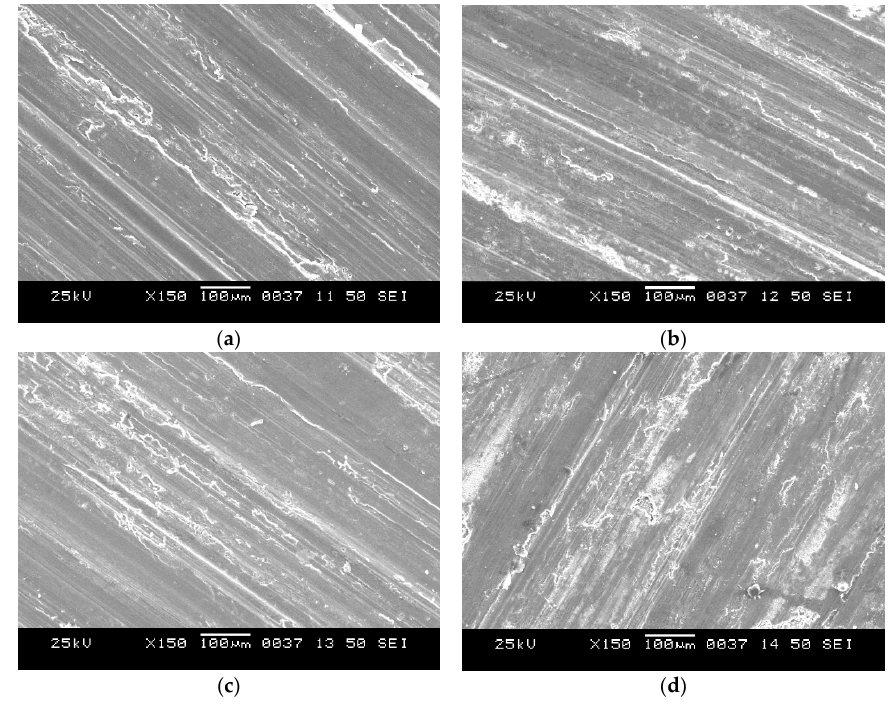
Figure 9. Worn surfaces of Al ‐ 2.5%TiB 2 for ( a ) holding time of 20 min, ( b ) holding time of 50 min and Al ‐ 5%TiB 2 for ( c ) holding time of 20 min, ( d ) holding time of 50 min.